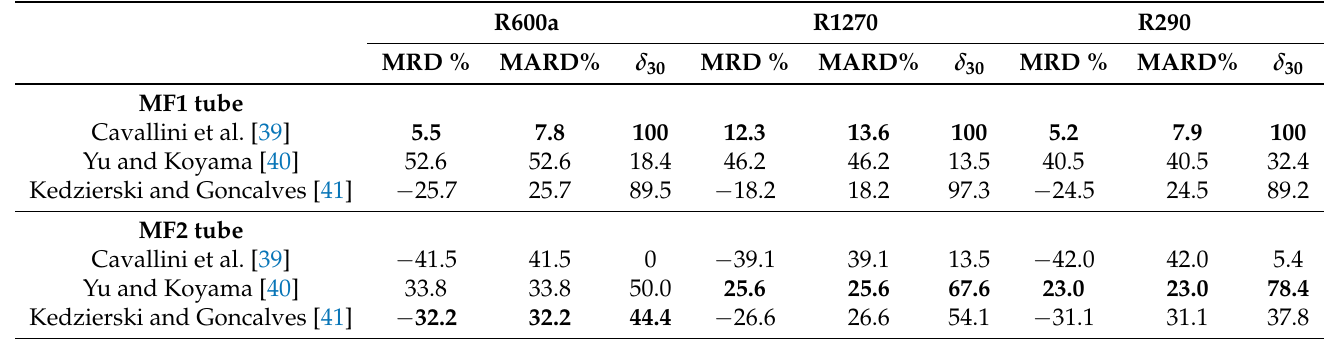
Table 6. Comparison between experimental data and correlations for prediction of HTC in microfinned tubes, with best correlations highlighted in bold.